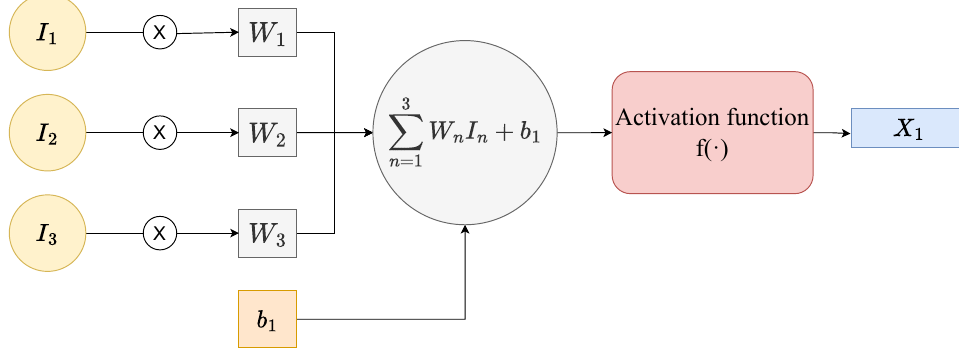
Figure 4. Schematic of a neuron shown for the computation of X 1 from Figure